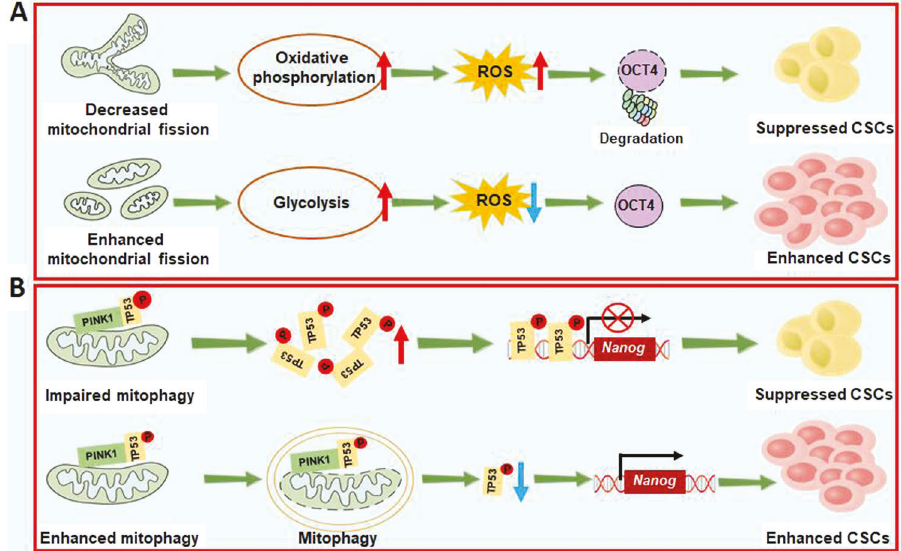
Fig. 6 Enhanced mitochondrial fi ssion and mitophagy promote cancer stemness maintenance in liver cancer. A Enhanced mitochondrial fi ssion promotes metabolic switching from oxidative phosphorylation to glycolysis, thereby reducing ROS-mediated degradation of OCT4 and promoting cancer stemness maintenance in liver cancer. B When mitophagy is enhanced, p53 phosphorylated by PINK1 is degraded by mitophagy, leading to increased expression of NANOG. In contrast, impaired mitophagy promotes the nuclear localization of TP53 and then inhibits the self-renewal ability of